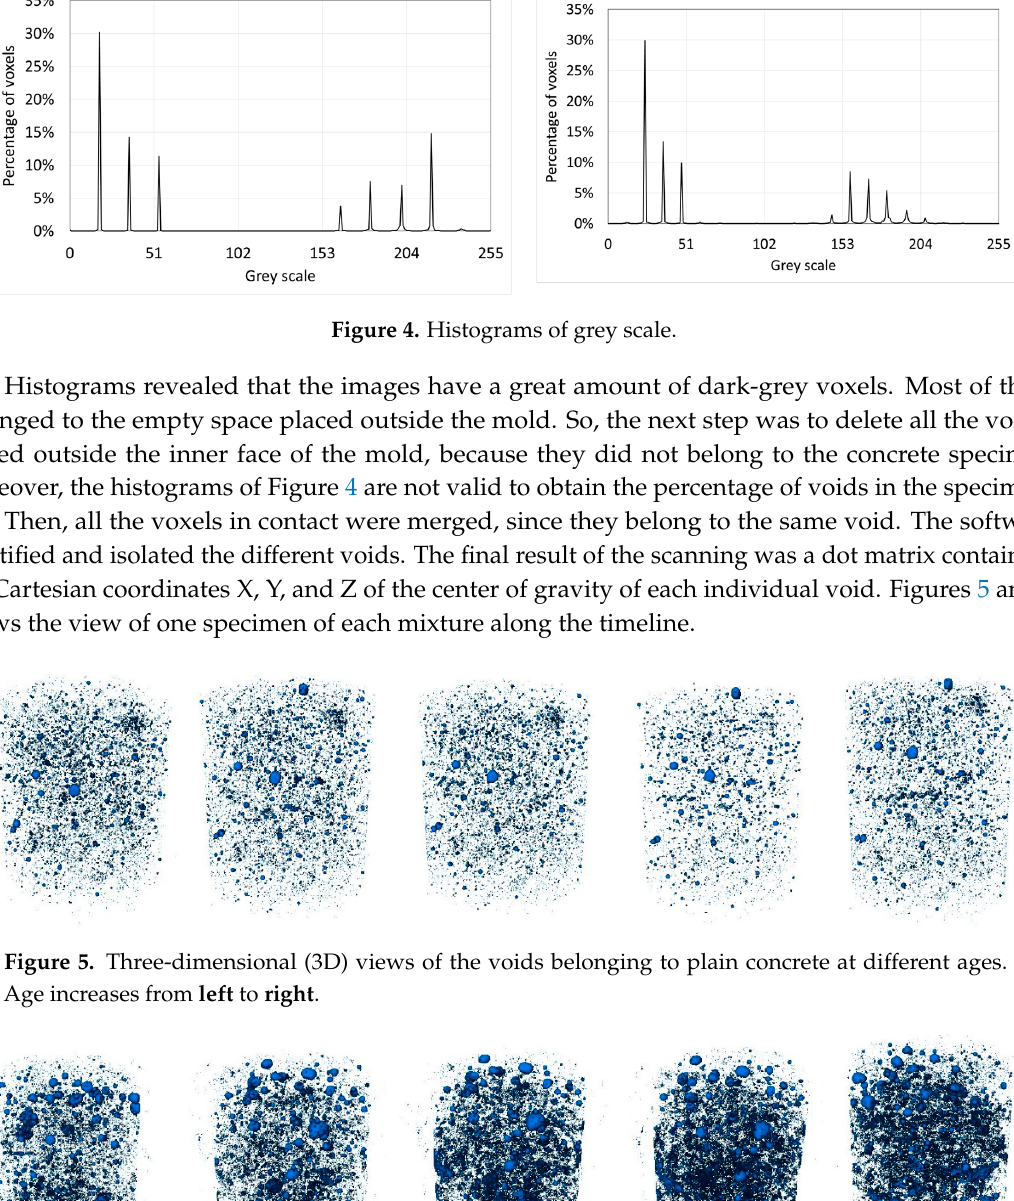
Figure 6. 3D views of the voids belonging to steel fiber-reinforced concrete at different ages. Age increases from left to right .